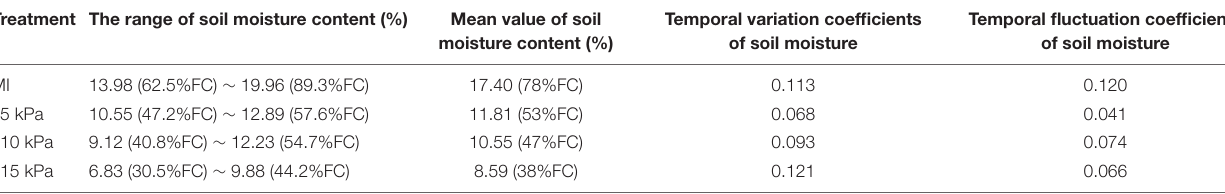
TABLE 2 | Soil volumetric moisture content and its stability parameters under different treatments. Treatment The range of soil moisture content (%) Mean value of soil